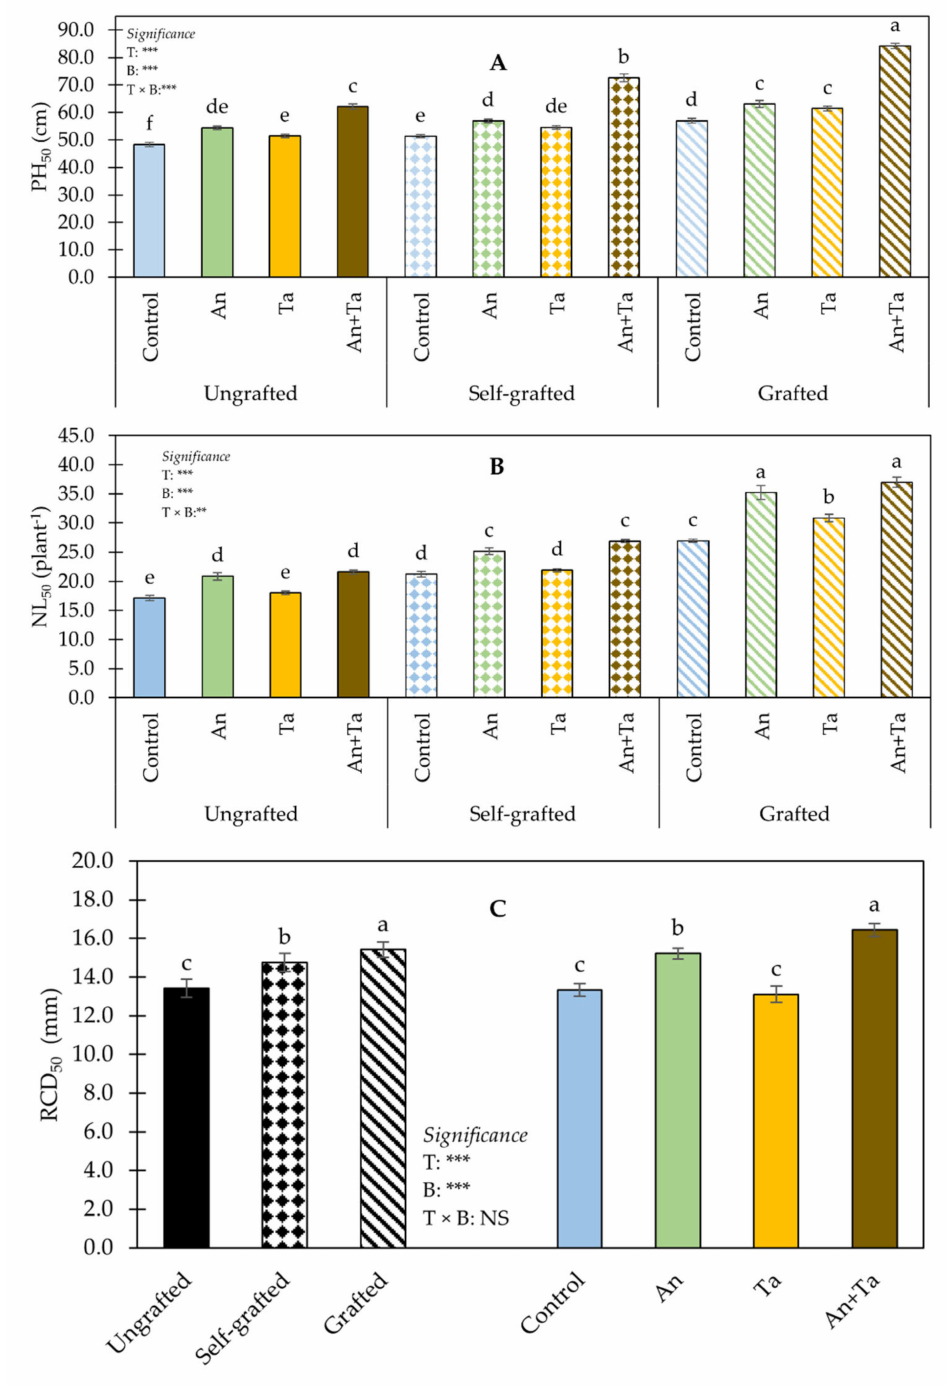
Figure 1. Effect of plant type (T) and biostimulant ( B ) on plant height 50 day after transplant (PH 50 ) ( A ), number of leaves 50 days after transplant (NL 50 ) ( B ) and root collar diameter 50 days after transplant (RCD 50 ) ( C ) of ‘Birgah’ F 1 eggplant. Bars show means ± SE. Bars with same letter are not significantly different accordingly to Tukey’s test at p ≤ 0.05. Significance: NS non-significant; ** significant at p ≤ 0.01; *** significant at p ≤ 0.001. An: Ascophyllum nodosum ; Ta: Trichoderma atroviride